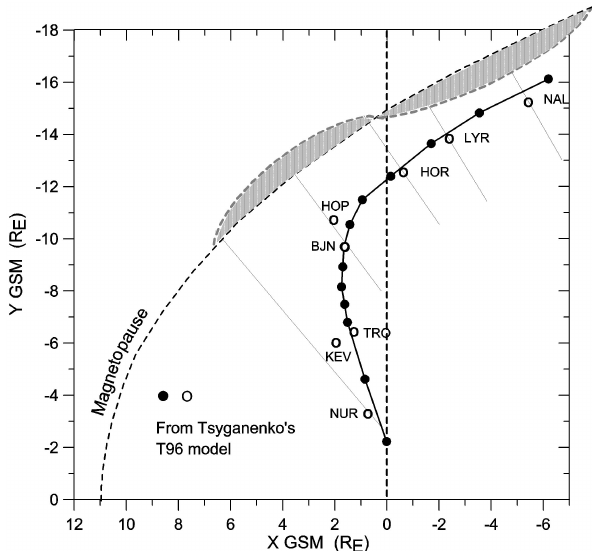
Fig. 10. The open circle points are determined via the T96 model as the conjugate point of these ground stations over the XY GSM plane. The solid circles are produced, again, via the T96 model for a hypothetic ground chain of stations with constant latitude equal to 19.2 ◦ . This figure corresponds to the event of day 181, 2001, at 05:00 UT, with D st =18nT, IMF B y = − 3nT and B z = − 1nT, and solar wind pressure 2nPa. For this event, the magnetopause sur- face wavelength is ∼ 16R E , and therefore different stations are as- sociated with different amounts of magnetopause surface displace- ments.